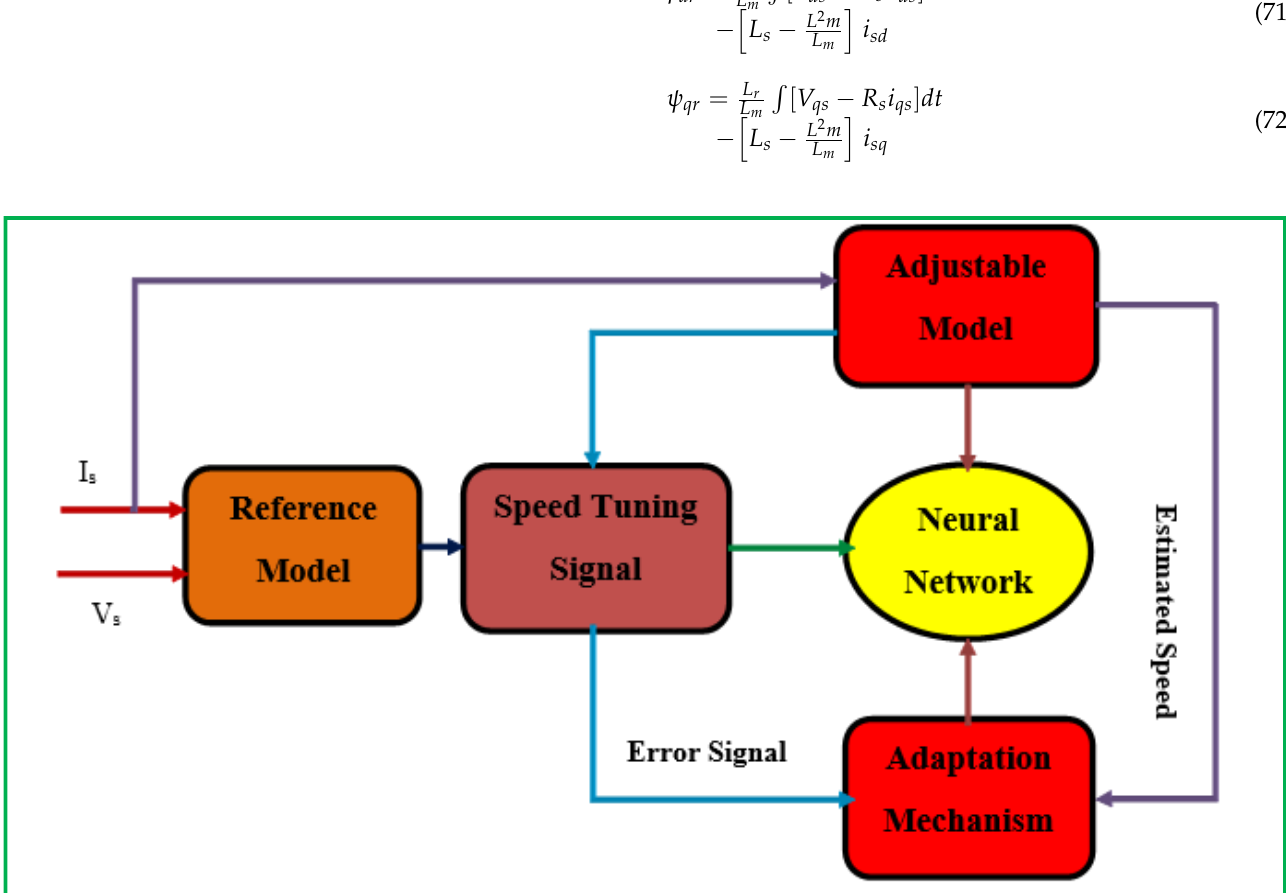
Figure 18. Model reference adaptive system and control.